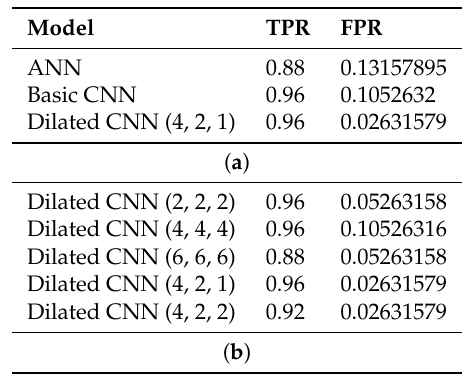
Table 5. TPR (True Positive Rate) and FPR (False Positive Rate) measures compared across ( a ) Simple ANN, Basic CNN and Dilated CNN. ( b ) combinations of dilation rates for the different convolution layers.